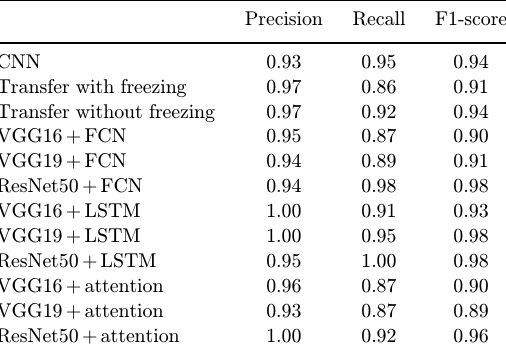
Table 7. Classi¯cation report of the violent